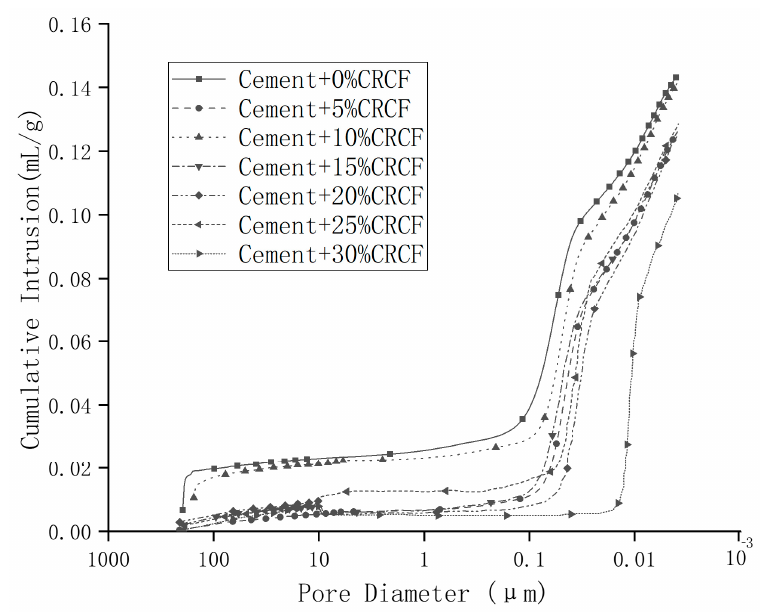
Figure 18. Cumulative mercury intrusion of the 7-day-cured hardened paste samples.